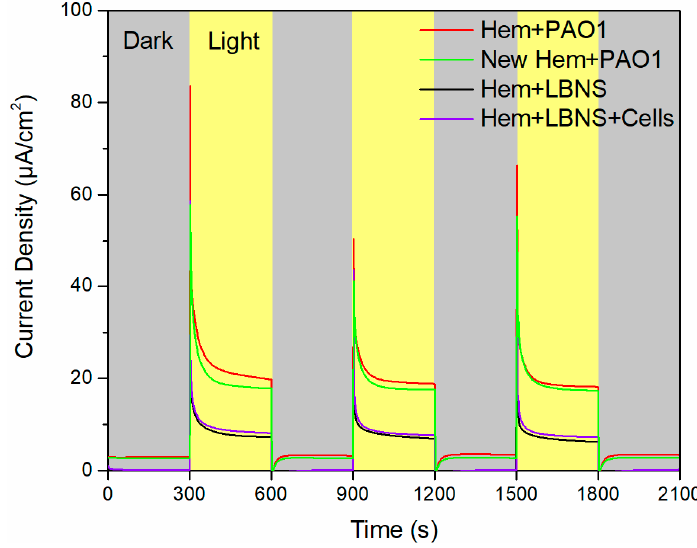
Figure 7. Amperometric I–t curves of the light-hematite-PAO1 system with different conditions under light on/off cycles.